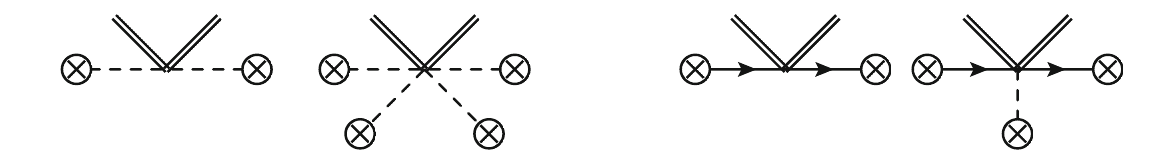
Fig. 15 Various vertices containing two internal graviton lines. Here the dashed line is the scalar, the solid line with arrow is the fermion, while the double line depicts the graviton. The lines ending with a circle containing a cross are external legs i −